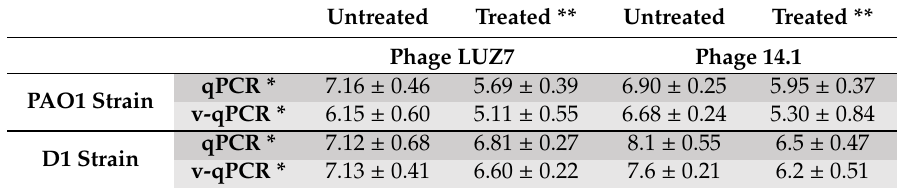
Table 8. Relative cell quantification of 24 h old biofilms untreated and treated with bacteriophages.